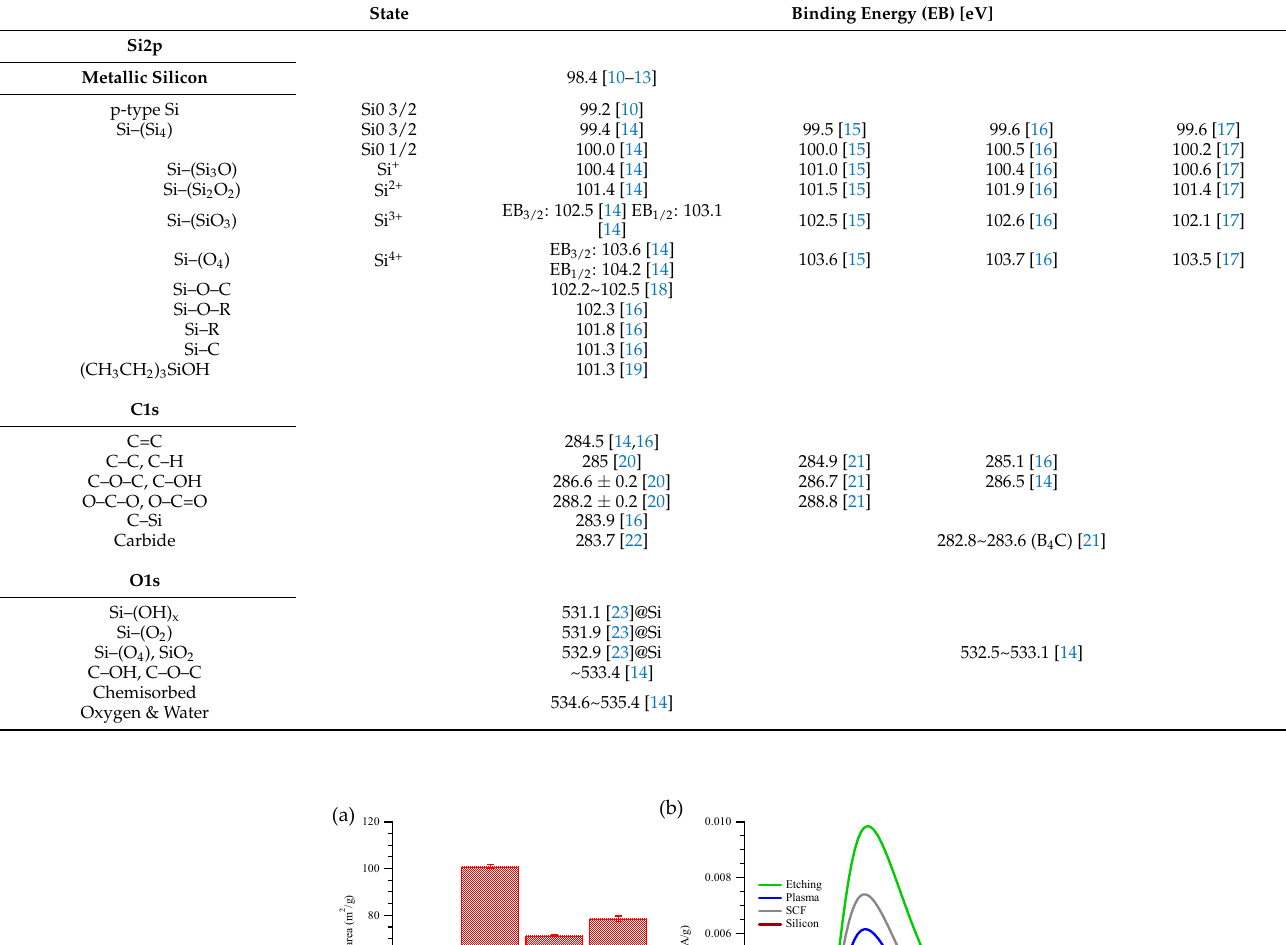
Table 1. Chemical structure and binding energy (EB) present in the samples.